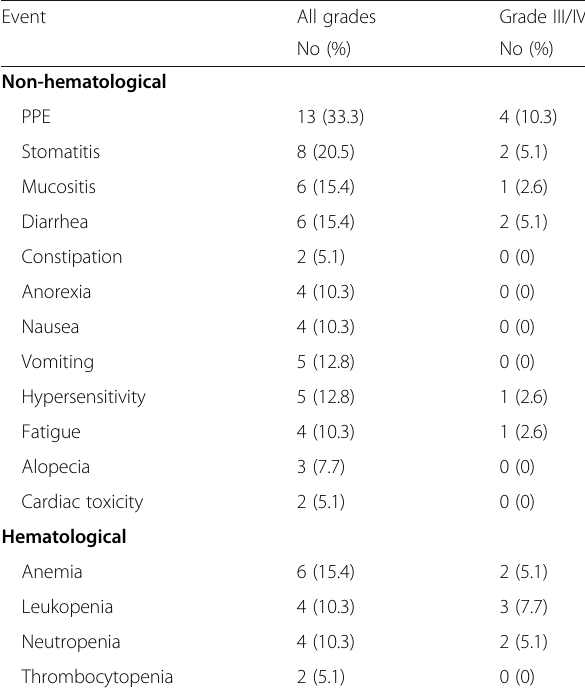
Table 3 Toxicity of pegylated liposomal doxorubicin in the studied